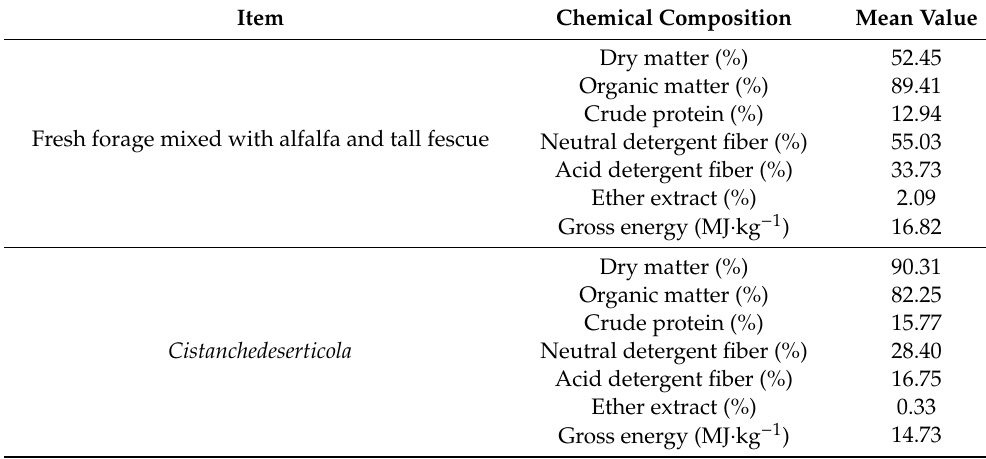
Table 1. Chemical composition of feed ingredients of experimental diets (dry matter (DM) basis). Item Chemical Composition Mean Value